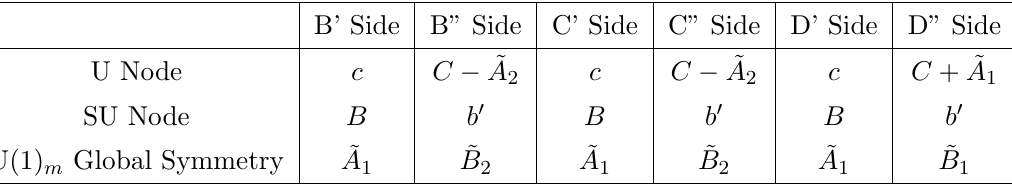
Table 3 . Matching of the intermediate theories. Note the matching of theory B’ and B" generalizes for any internal matching, except for the very last. Here, ~ B 2 is the background gauge (cid:12)eld associated with the new global symmetry we get from gauging ~ A 2 .